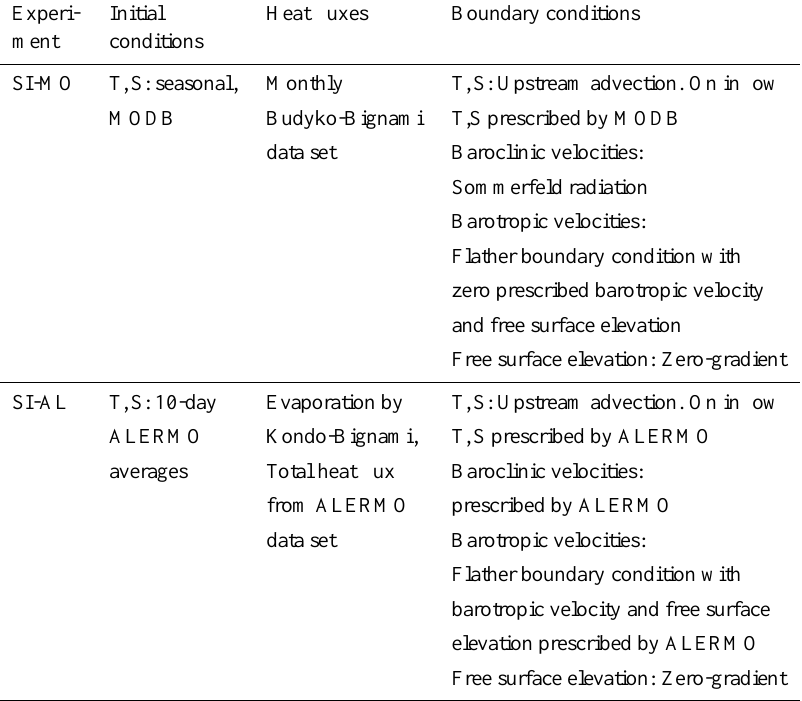
Table 2. The two main simulation-experiments Experi- Initial Heat fluxes Boundary conditions ment conditions SI-MO T,S: seasonal, Monthly T,S: Upstream advection. On inflow MODB Budyko-Bignami T,S prescribed by MODB data set Baroclinic velocities: Sommerfeld radiation Barotropic velocities: Flather boundary condition with zero prescribed barotropic velocity and free surface elevation Free surface elevation: Zero-gradient SI-AL T,S: 10-day Evaporation by T,S: Upstream advection. On inflow ALERMO Kondo-Bignami, T,S prescribed by ALERMO averages Total heat flux Baroclinic velocities: from ALERMO prescribed by ALERMO data set Barotropic velocities: Flather boundary condition with barotropic velocity and free surface elevation prescribed by ALERMO Free surface elevation: